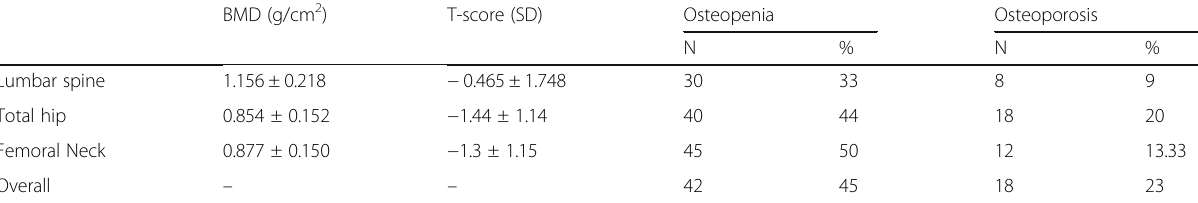
Table 2 Results of bone mass in hemodialysis patients BMD (g/cm 2 )